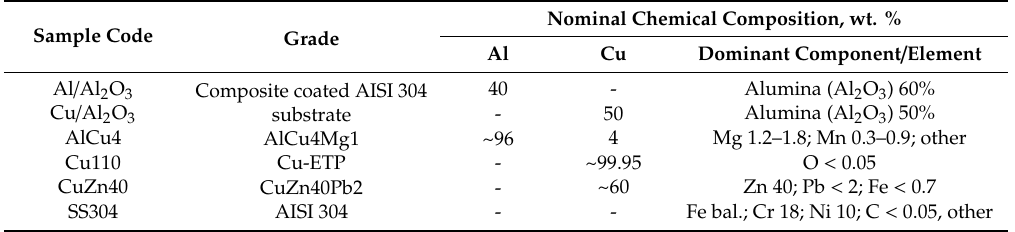
Table 2. Investigated materials: Grade, chemical composition and sample codes. Sample